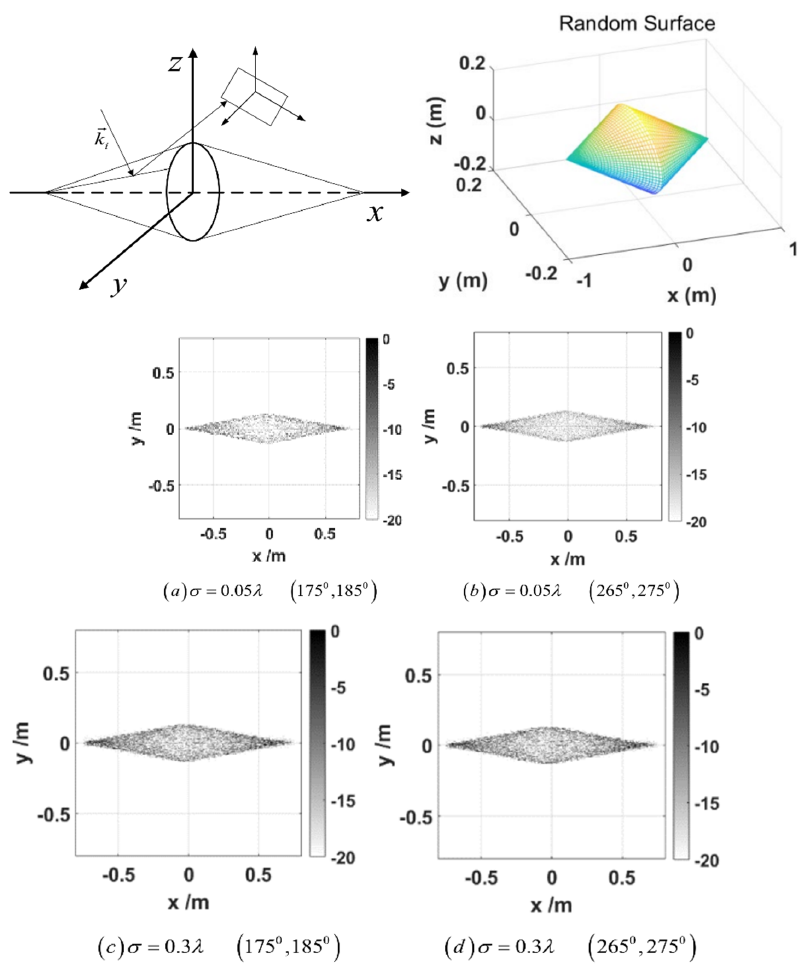
Figure 5. The effect of different root mean square heights and rotation angles on biconical ISAL imaging.